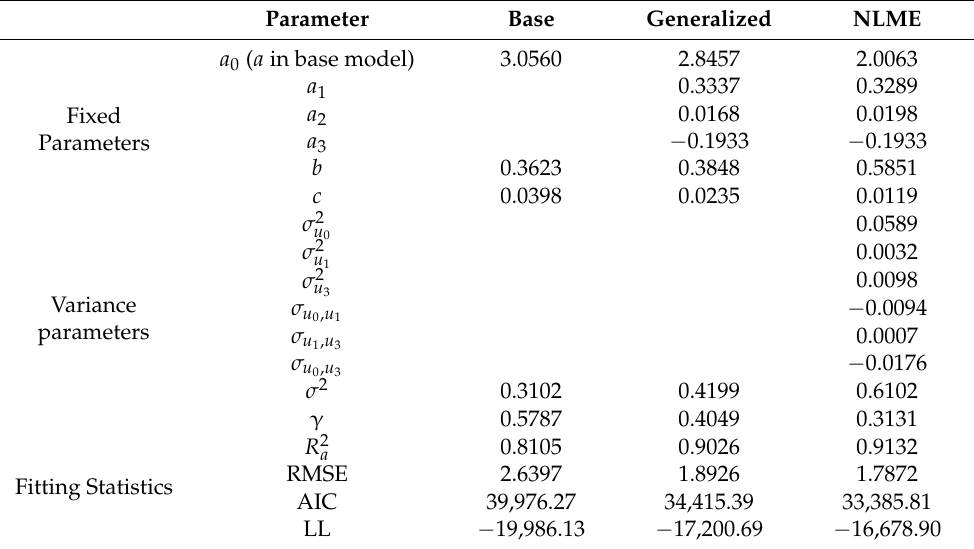
Table 2. Parameter estimates and fitting statistics for the base, generalized, and nonlinear mixed- effects (NLME)